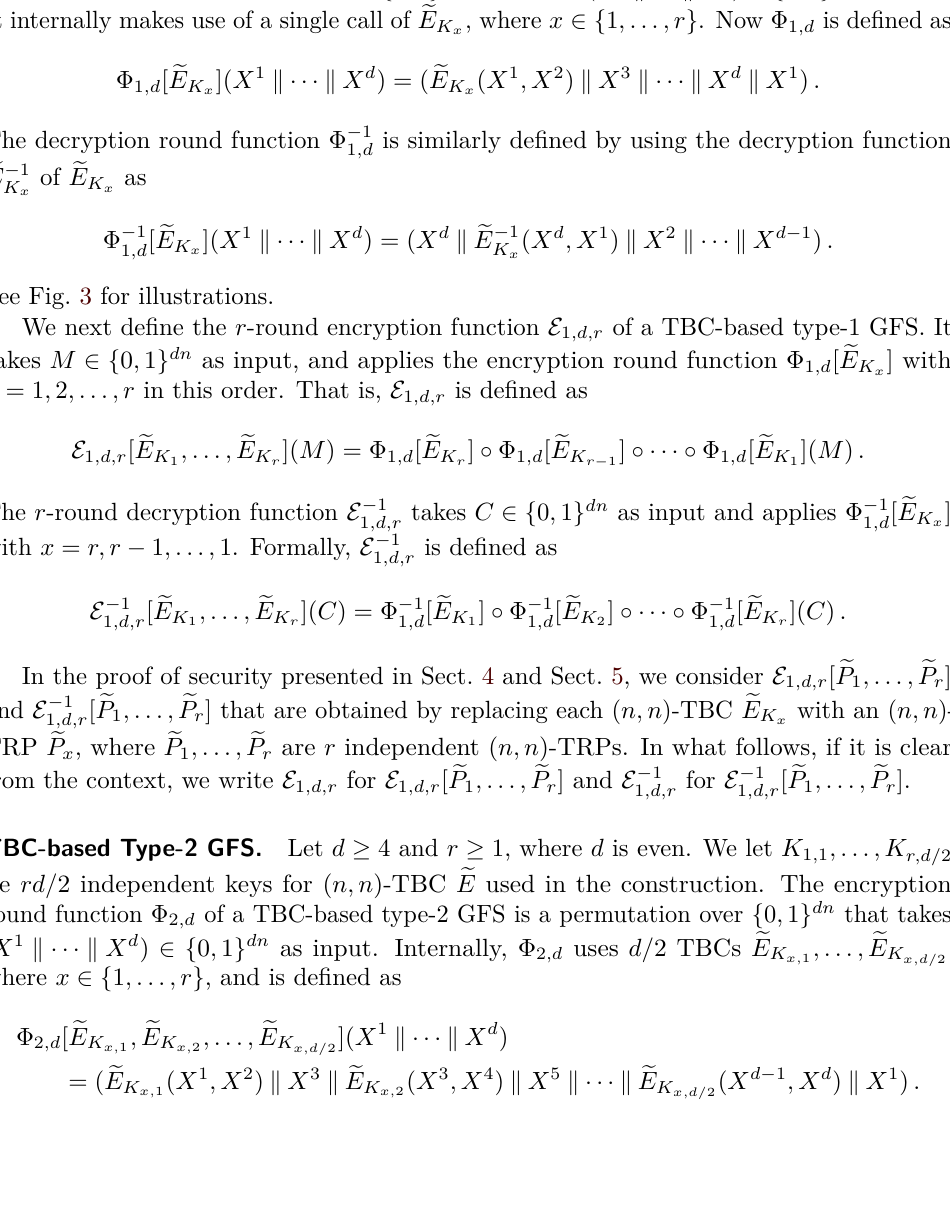
( X 1 , X 2 ). K x ( X d , X 1 K x